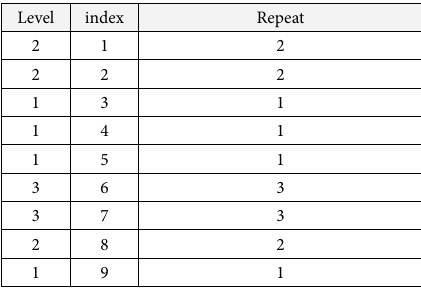
Table 7. Final Reachability Matrix